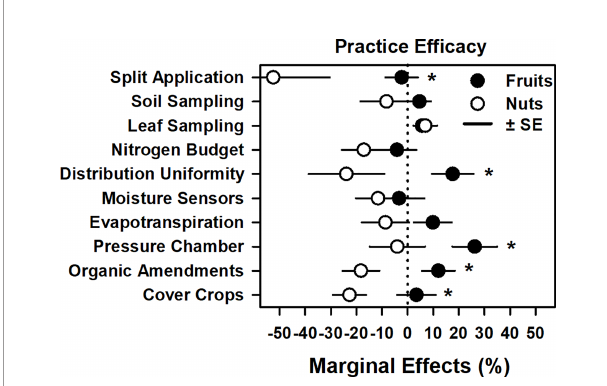
FIGURE 5 | Marginal effects plus and minus standard errors for practice ef fi cacy as a challenge to adoption of conservation practices for nitrogen (N) management by fruit and nut growers. Differences at p < 0.05 reported by asterisk (*) signify the effect is signi fi cant using an interaction term between fruit and nut growers within the logistic regression.